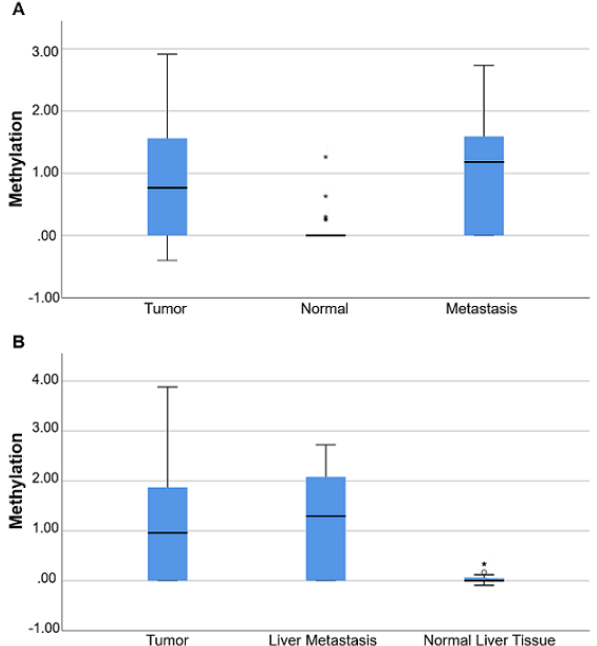
Figure 5. Quantitative methylation-specific PCR (QMSP) analyses of B4GALT1 in metastatic colorectal cancer (mCRC) tissues. Box plot (logarithmic scale) for B4GALT1 / ACT ratios determined by QMSP in: ( A ) Training set of tumor samples ( n = 24) and normal ( n = 22) and liver metastasis ( n = 27) (Group 1, Kruskal–Wallis test, p = 0.008); ( B ) validation set of tumor samples ( n = 15) and liver metastasis ( n = 22) and normal adjacent to the metastasis ( n = 15) (Group 2, Kruskal–Wallistest, p = 0.005). The boxes mark the IQR (interval between the 25th and 75th percentile). The lines inside the boxes denote median values. The whiskers represent the interval between the 10th and 90th percentiles. The asterisks (*) indicate outliers.